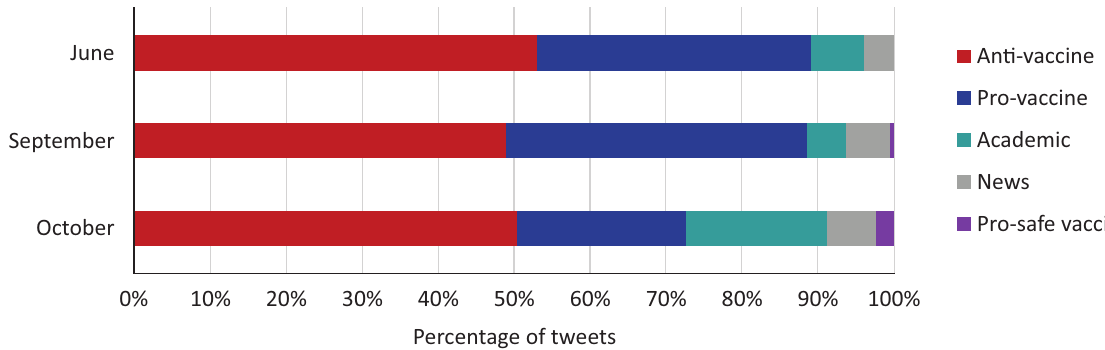
Figure 2. Percentage of tweets for each data collection and each category. Note: The total number of tweets analysed for each collection was 3573 in June, 1932 in September, and 3778 in